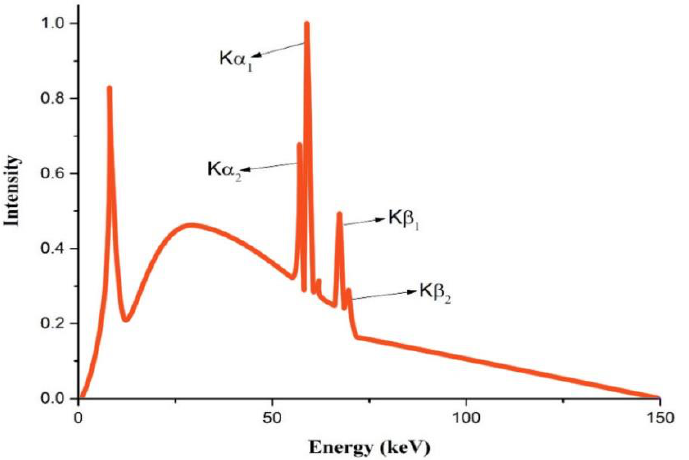
Figure 4. X-ray energy spectrum applied to the simulations obtained by the TASMIC package.